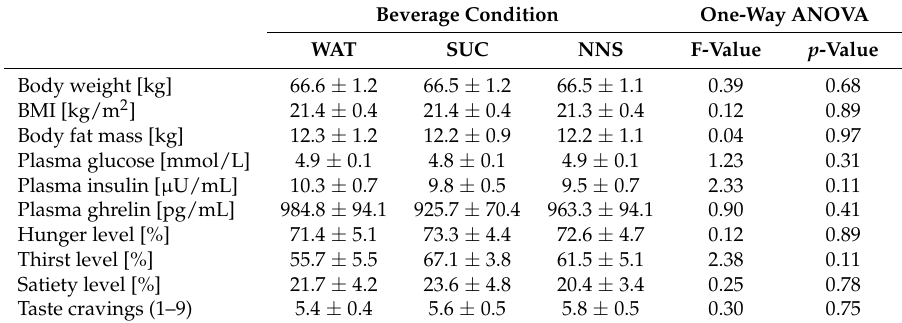
Table 1. Study participants’ anthropometric, metabolic, and behavioral characteristics at baseline.